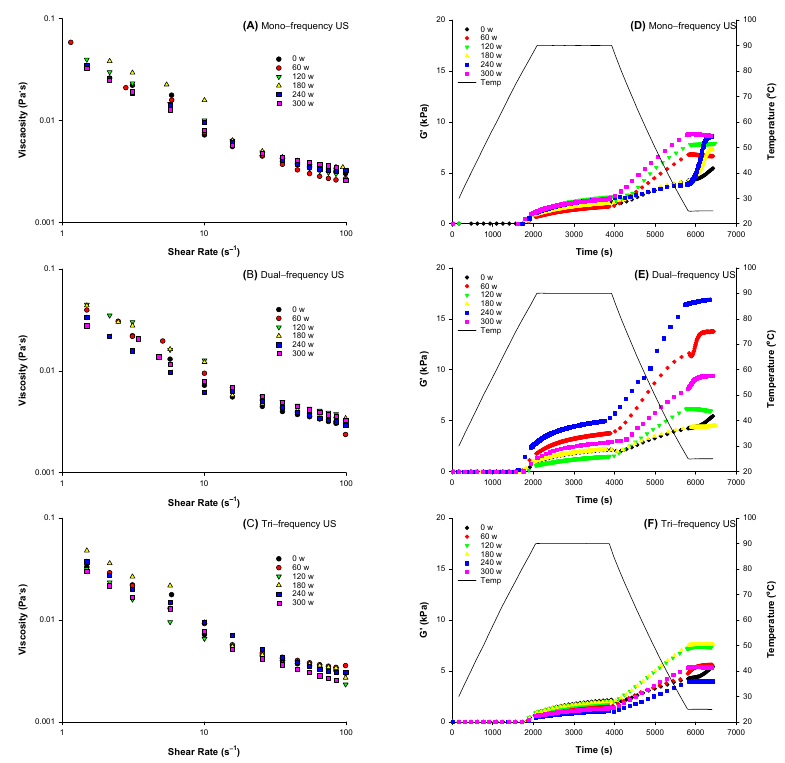
Figure 1. Viscosity ( A – C ) of ultrasound pretreated WPI emulsions and storage modulus G (cid:48) ( D – F ) change in emulsions prepared with whey protein pretreated by ultrasound at different ultrasonic frequency mode and ultrasonic power during heating and cooling